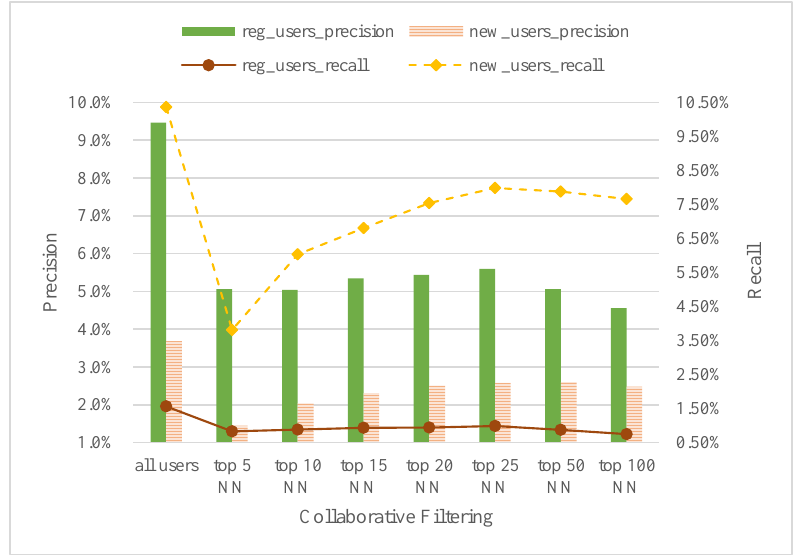
Figure 5. Precision and recall comparison of regular users and new users for collaborative filtering module with different values of top N users obtained by nearest neighbour (NN)